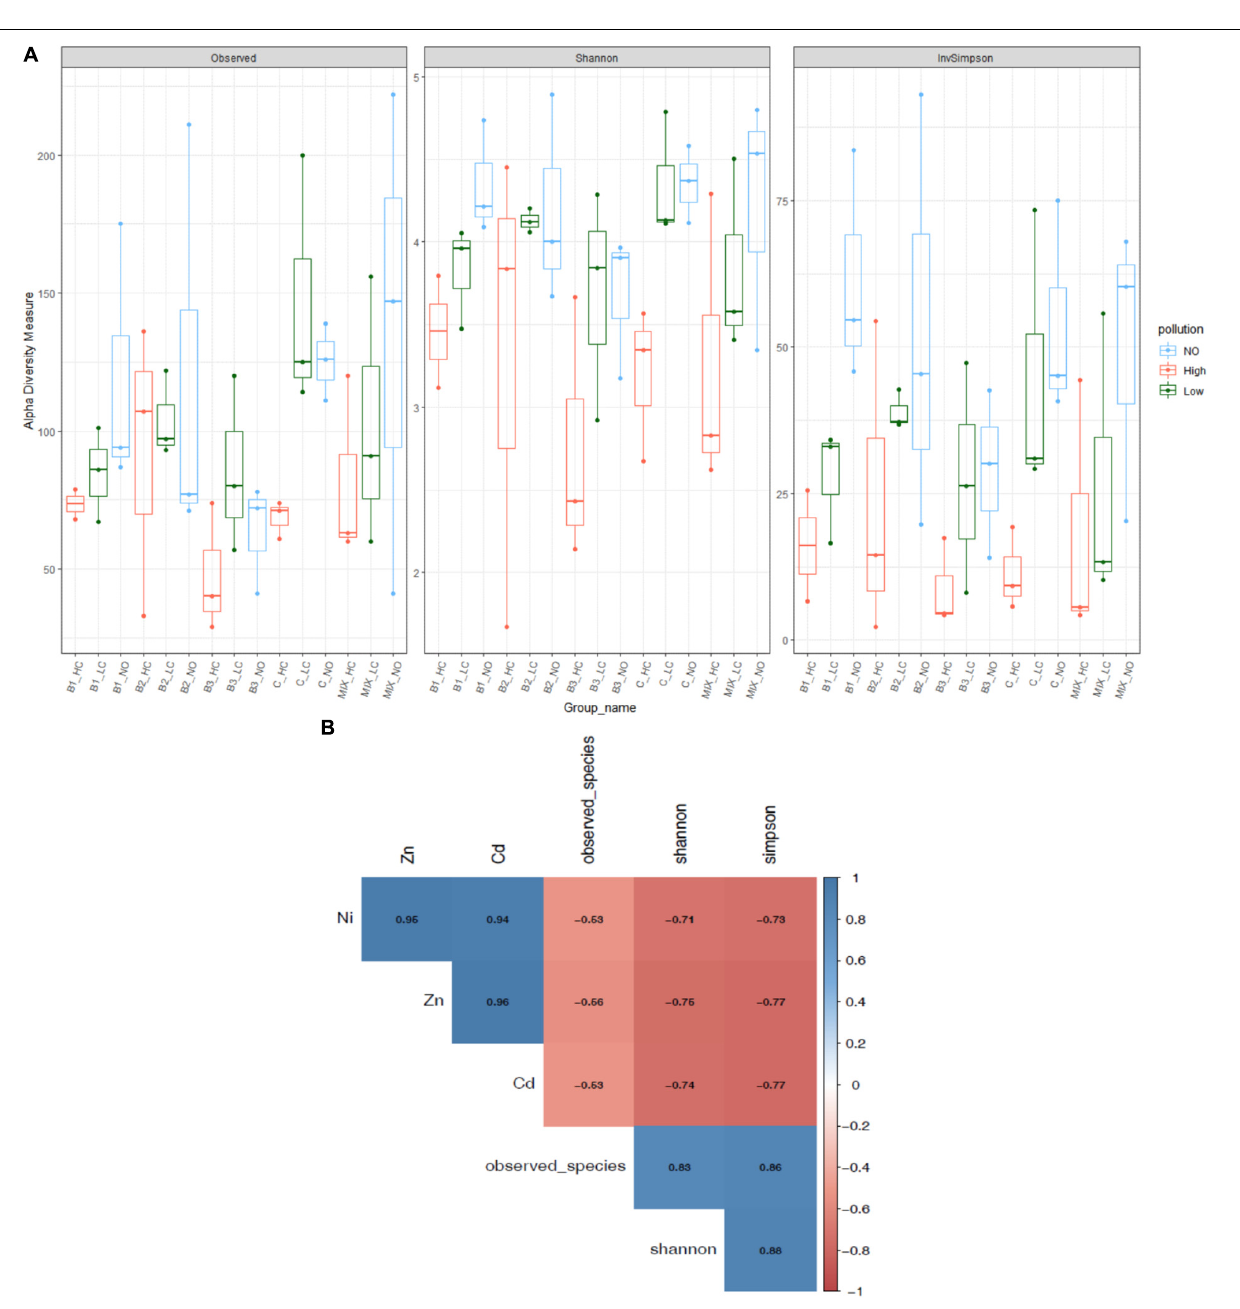
FIGURE 1 | Alpha diversity indices of root endophytic communities among the different bioaugmented treatments (A) and the correlation of them with the metal concentration in the roots (the significant correlation coefficients are indicated) (B) . The scale colors denote whether the correlation is positive (closer to 1, blue circles) or negative (closer to –1, red circles) between the diversity indices and metal